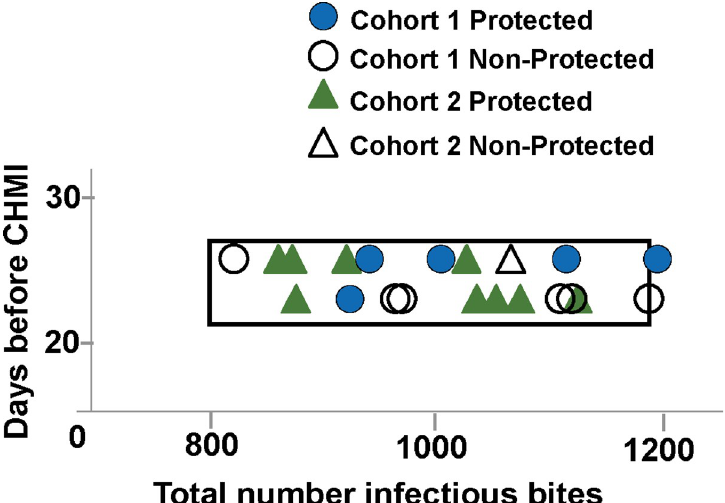
Fig 5. Comparison of total number of infectious bites and time to CHMI in Cohort 1 and Cohort 2 with the target range of infectious bites. The total number of infectious bites and days between final immunization and CHMI are compared for Cohort 1 (protected: blue circles; non-protected: open circles) and Cohort 2 (protected: green triangles; non-protected: open triangles). All Cohort 1 and Cohort 2 subjects fell within the target box except one protected subject and one non-protected subject in Cohort 1 that fell just outside the target box. The distribution of subjects in Cohort 1 and Cohort 2 showed no association of protection with total numbers of infectious bites or time (days) before CHMI.